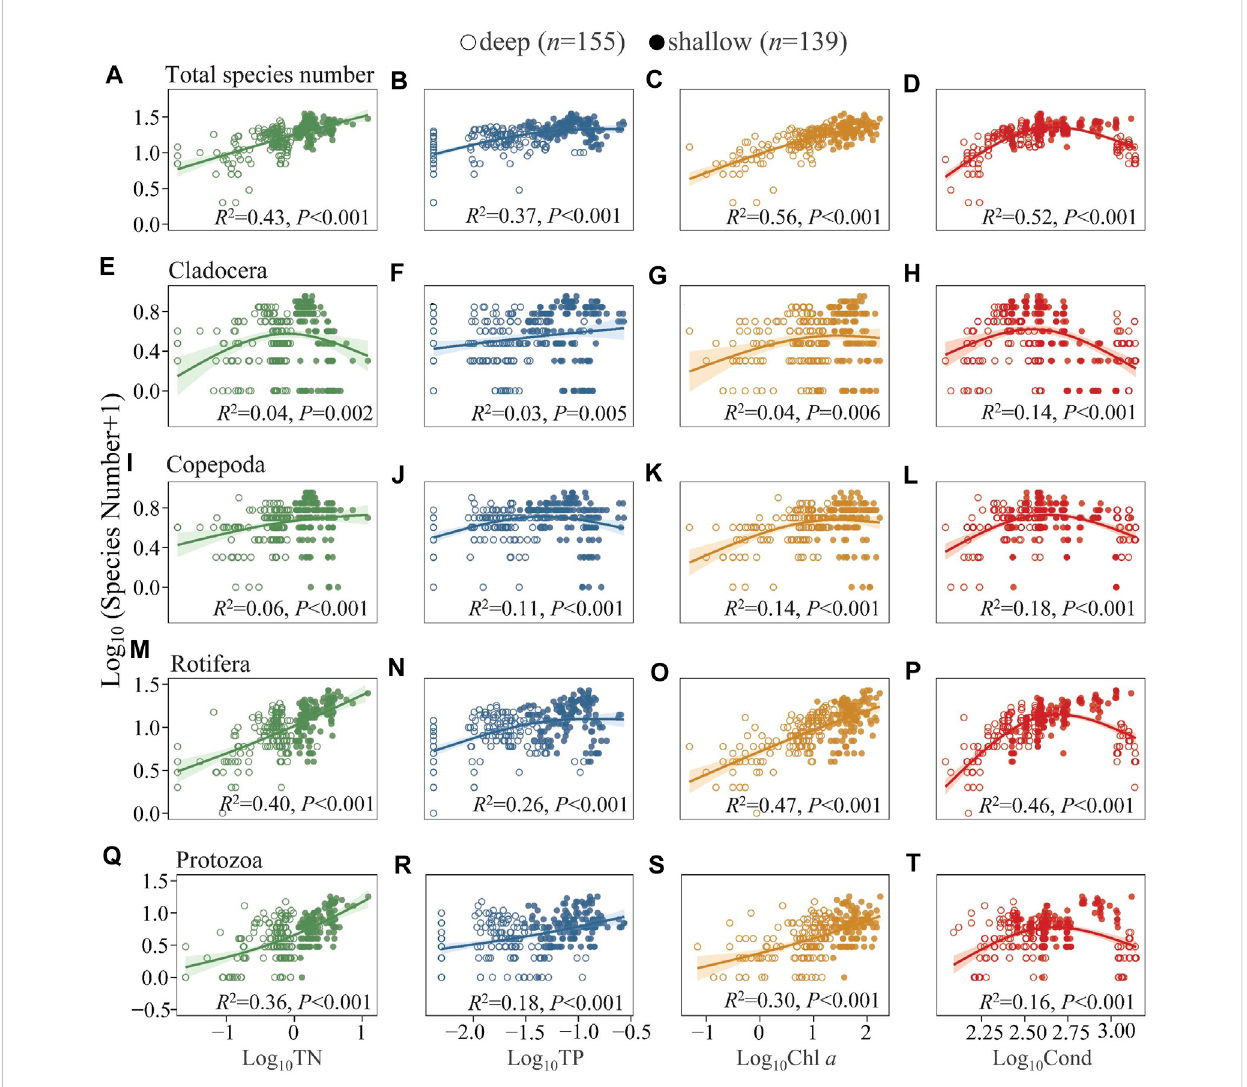
Generalized additive model of the relationships between TN, TP, Chl a, and Cond with the species number of total zooplankton (A – D) , Cladocera (E – H) ,Copepoda (I – L) ,Rotifera (M – P) ,andProtozoa (Q – T) inthestudiedlakes.Thestudiedlakesweredividedintotwogroupsaccordingtomeandepth (Z), i.e., DC, XYH, YLH, and QLH as shallow lakes with Z < 10 m, LGH, CH, YZH, and EH deep lakes with Z > 10 m. See Supplementary Table S3 for model